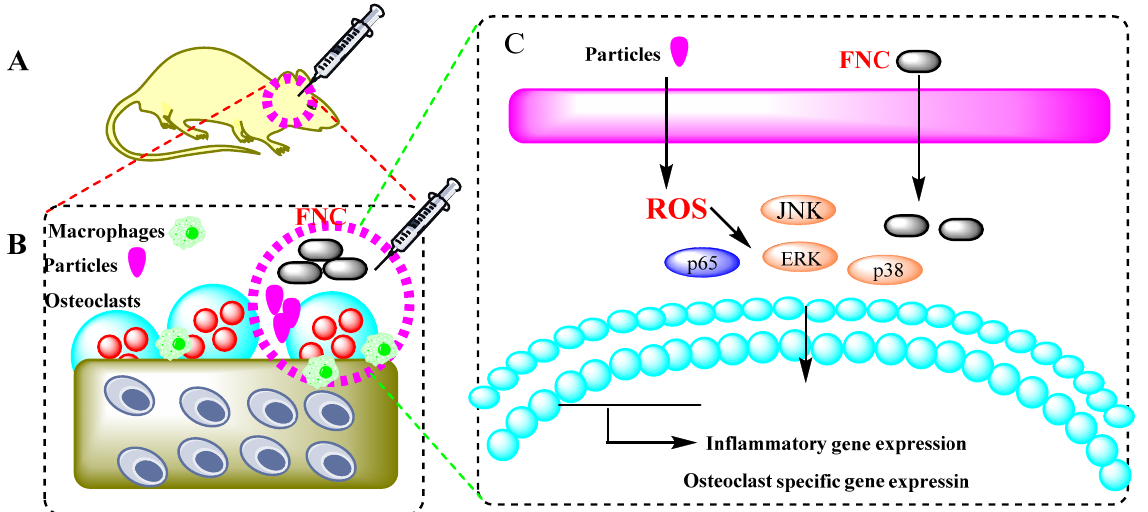
Figure 6. A schematic diagram of FNC inhibited inflammation and osteoclastogenesis. ( A ) Local injection of FNC at osteolytic sites. ( B ) Materials interaction between macrophages and osteoclasts influenced inflammation and osteoclastogenesis. ( C ) FNC was phagocytosed, and FNC exhibited the effect of ROS adsorption. Subsequently, the inflammatory and osteoclast-specific genes were down-regulated [101].